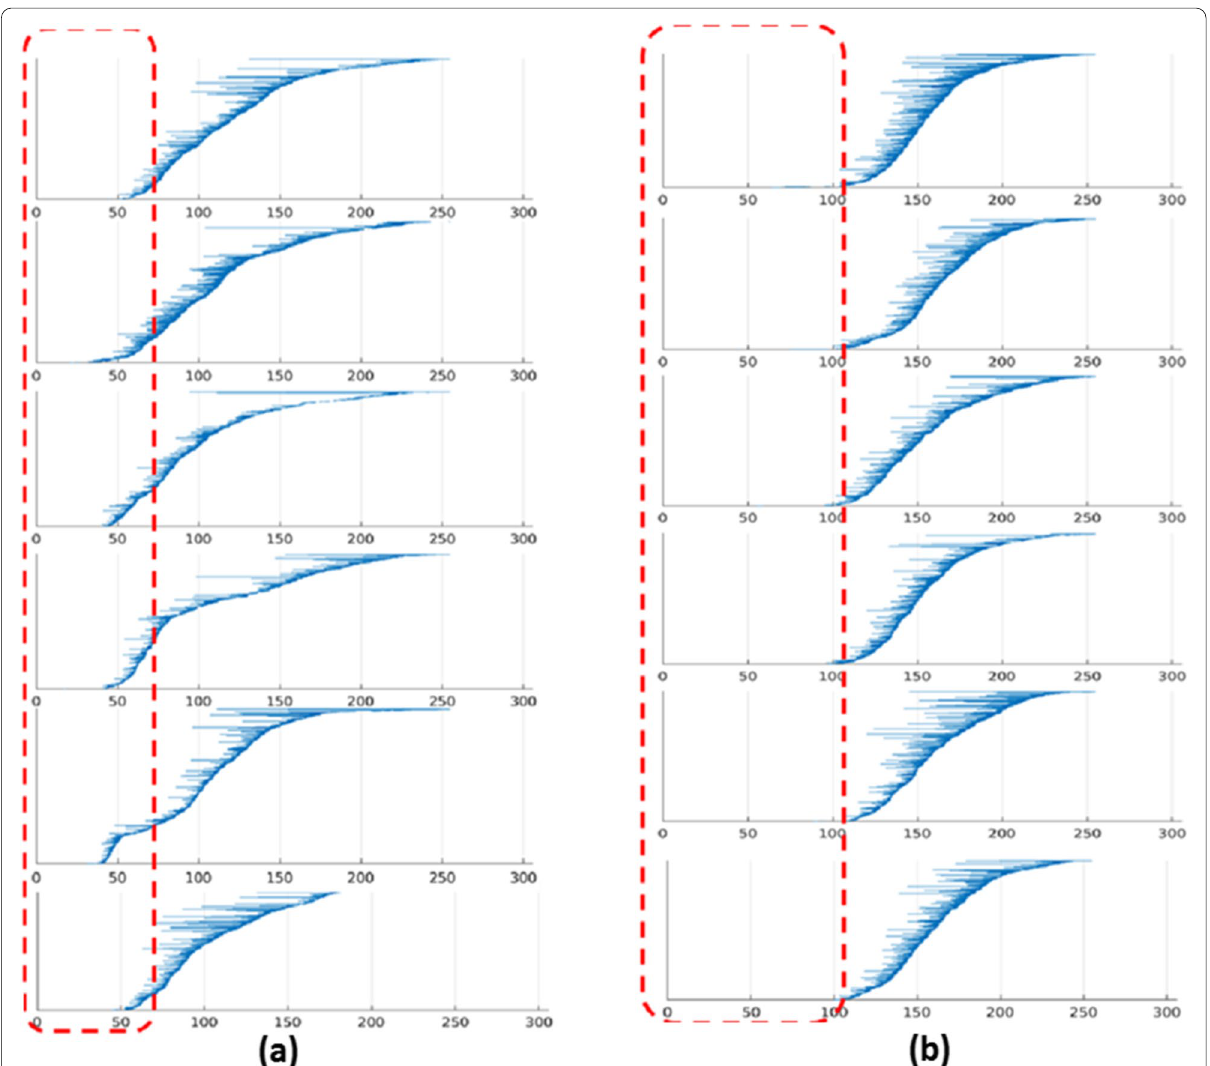
Fig. 2 A barcode representation of hepatic decompensation status within a year. The horizontal axis line corresponds to the parameter ɛ , and the vertical axis line is the ordering of the homology generators. Note that the vertical placement is only introduced for display and does not have any intrinsic meaning. a Patients with hepatic decompensation within a year group exhibit Betti numbers typically between 0 and 50. b Patients without hepatic decompensation exhibit Betti numbers between 0 and 100. With the red box-based indicator, we can see a clear